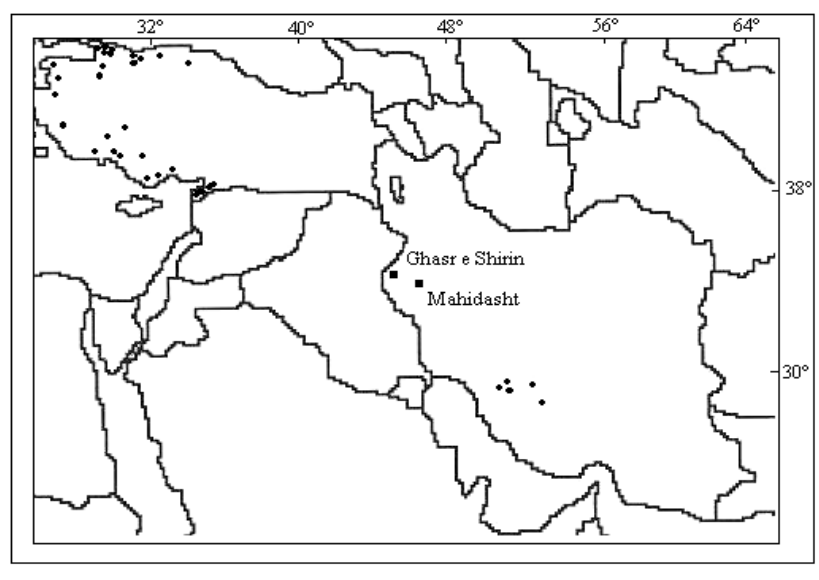
F IG .1.- Distribution map for M. capaccinii reported fro southern Iran ( (cid:19) ), western Iran ( (cid:18) ) and Turkey ( (cid:19) ). M ATERIAL AND M